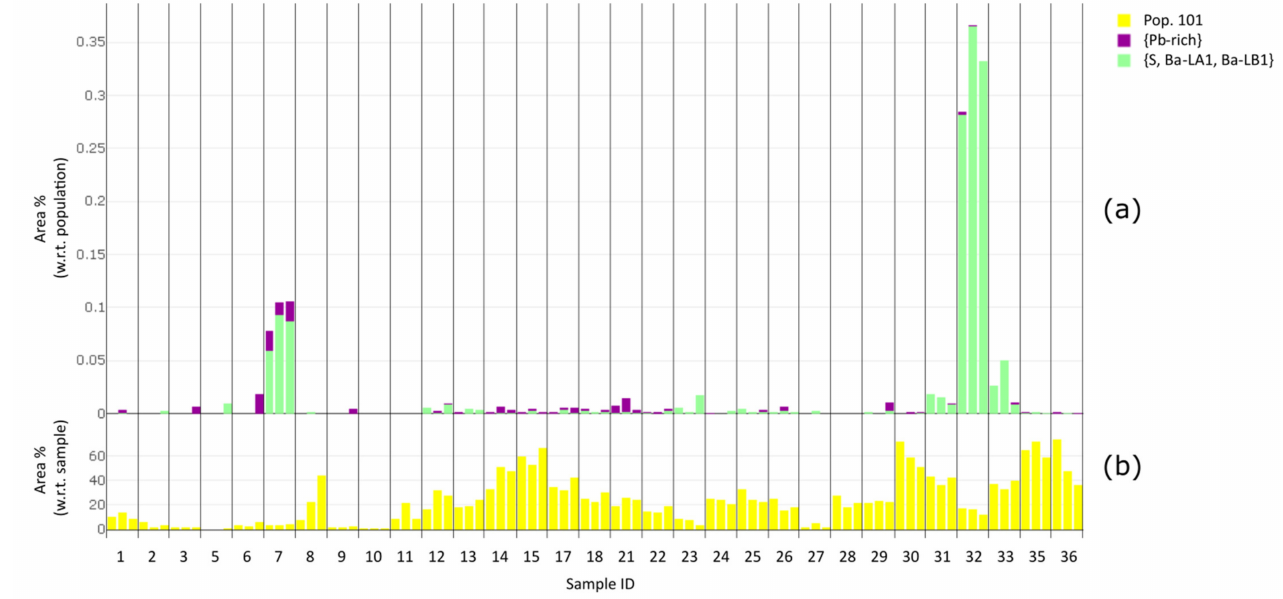
Figure 9. ( a ) Ba-sulphate (green) and Pb-rich (purple) abundances for the ubiquitous “quartz-rich” grain population 101 (Pop.101), reported as area % with respect to the population. ( b ) Abundance of the grain population per sample. All individual triplicate analyses are